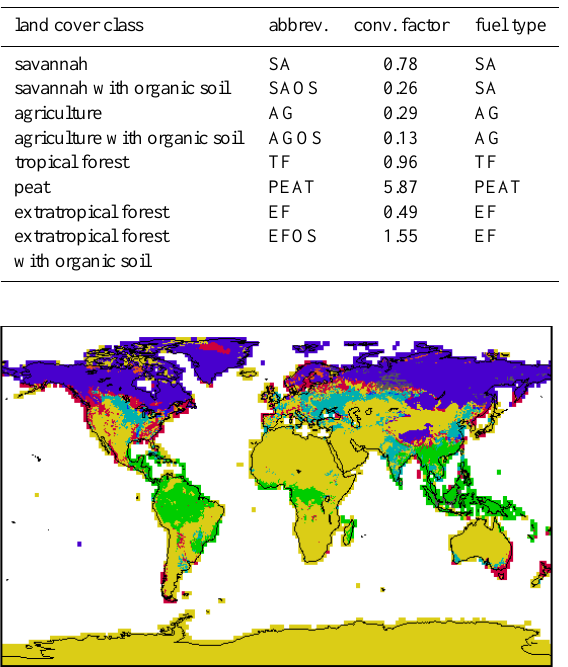
Table 2. Land cover classes l used in GFASv1.0 (Col. 1), their abbreviation in this manuscript (Col. 2), the associated conver- sion factor β l [kg ( dry matter ) MJ − 1 ] linking fire radiative power in GFASv1.0 and dry matter combustion rate in GFEDv3.1 (Col. 3), and fuel type used for species emission calculations in Eq. (36) (Col. 4). β l is used in Eq. (35) to calculate the dry matter com- bustion rate estimate of GFASv1.0.